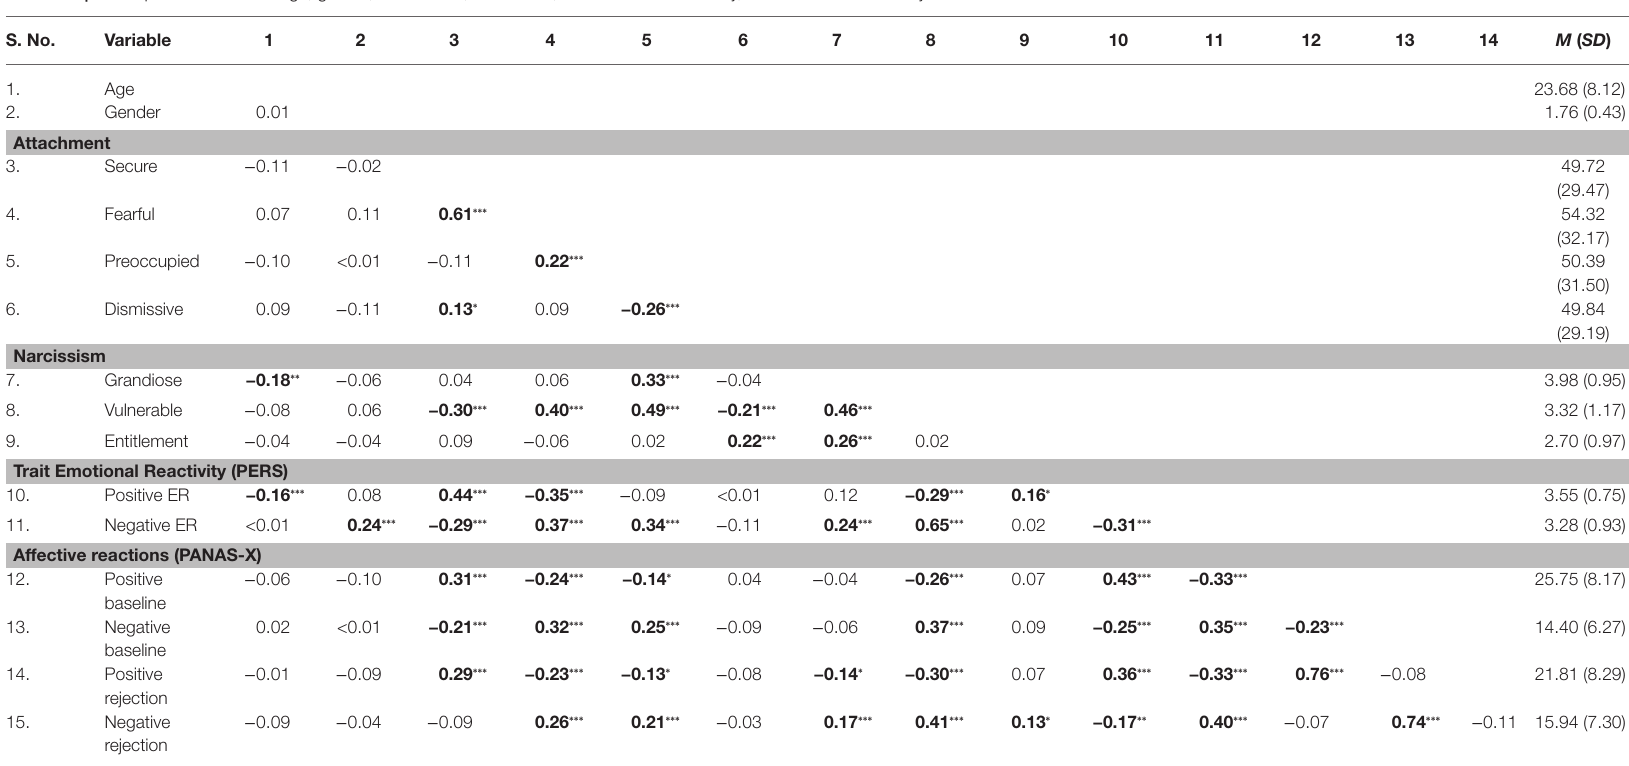
TABLE 1 | Descriptive statistics for age, gender, attachment, narcissism, trait emotional reactivity, and affect after each Cyberball round. S.